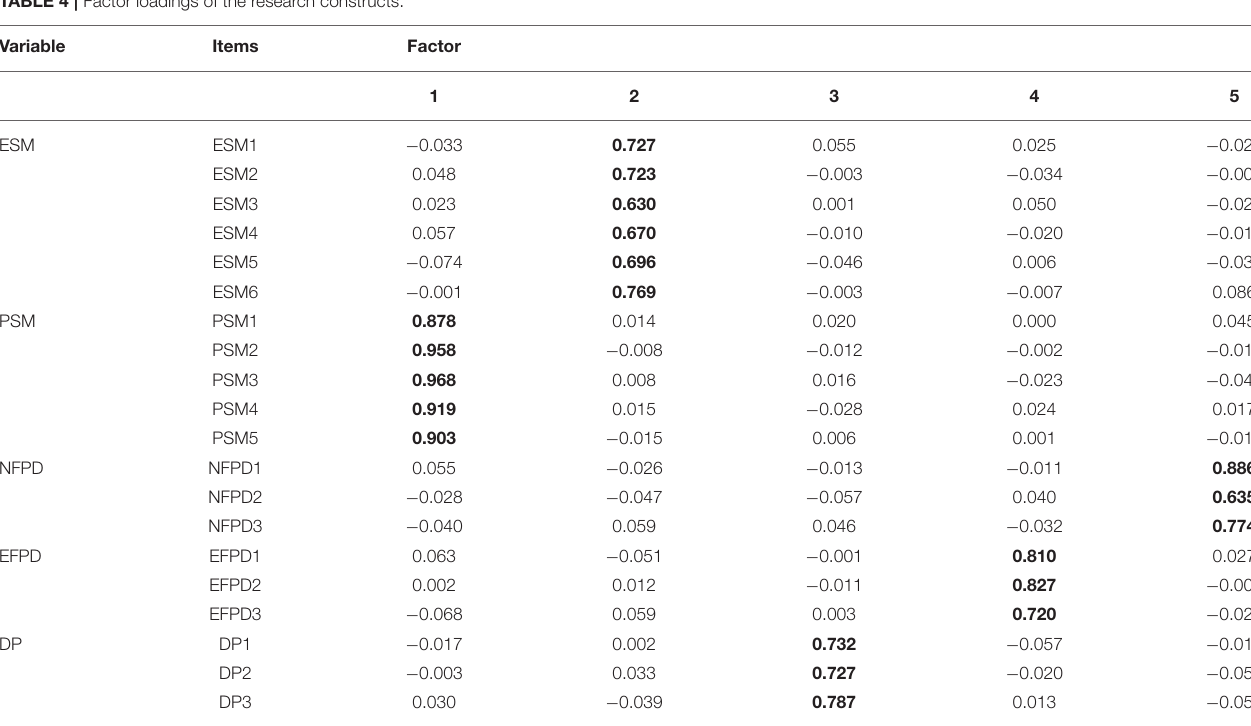
TABLE 4 | Factor loadings of the research